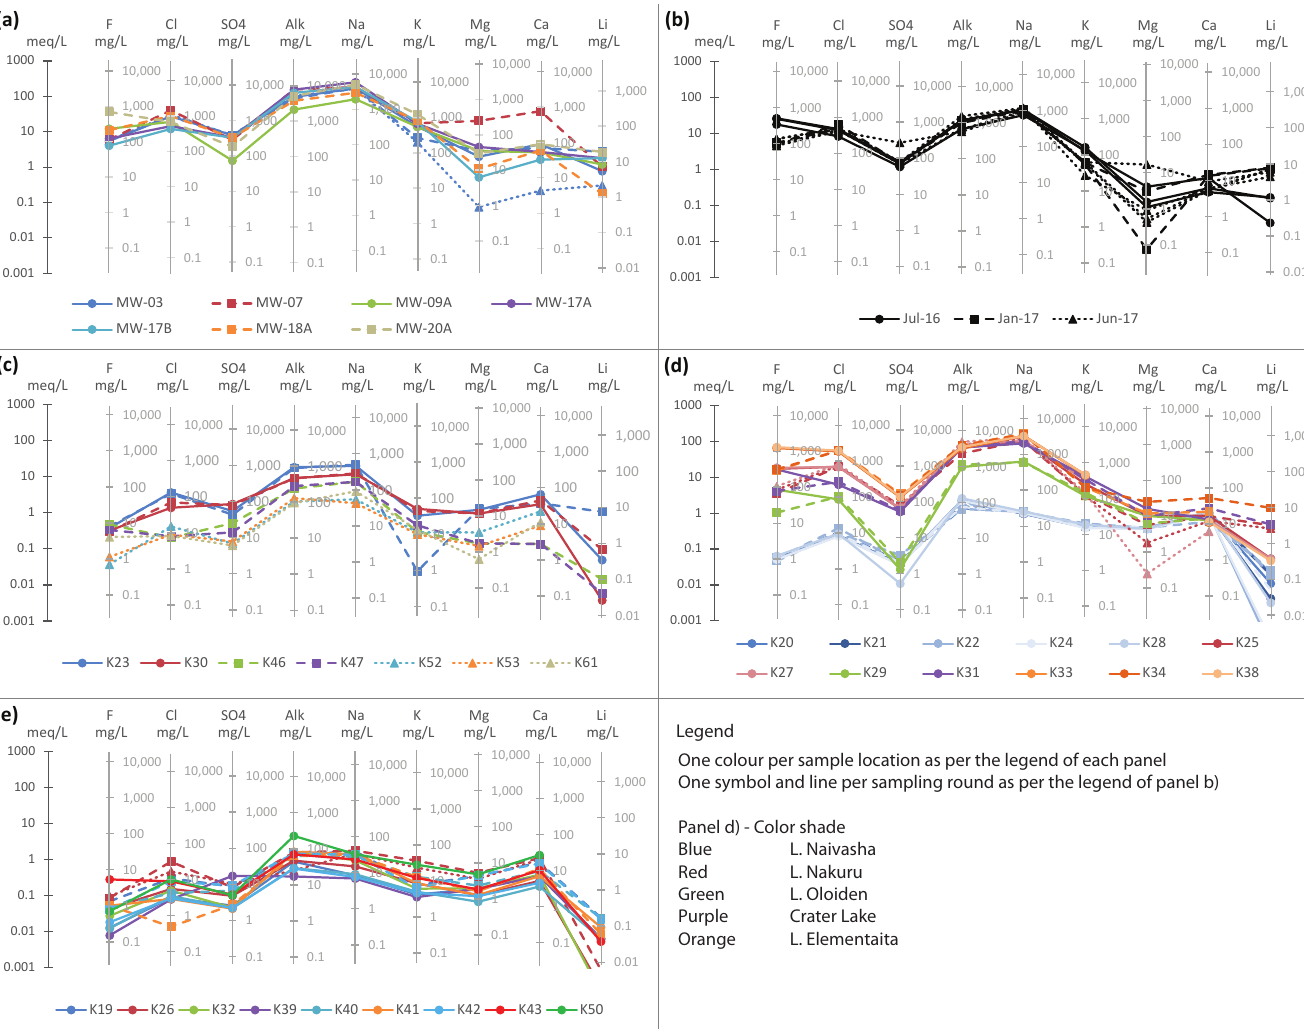
One colour per sample location as per the legend of each panel One symbol and line per sampling round as per the legend of panel b)